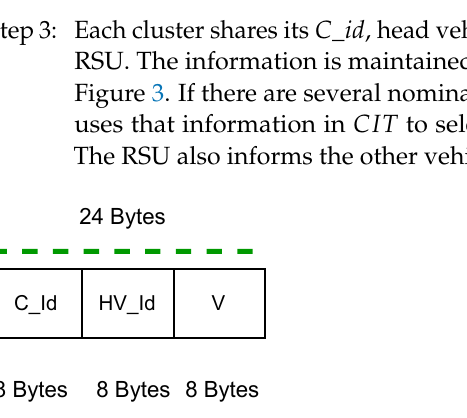
Figure 3. RSU Cluster Information Table ( CIT